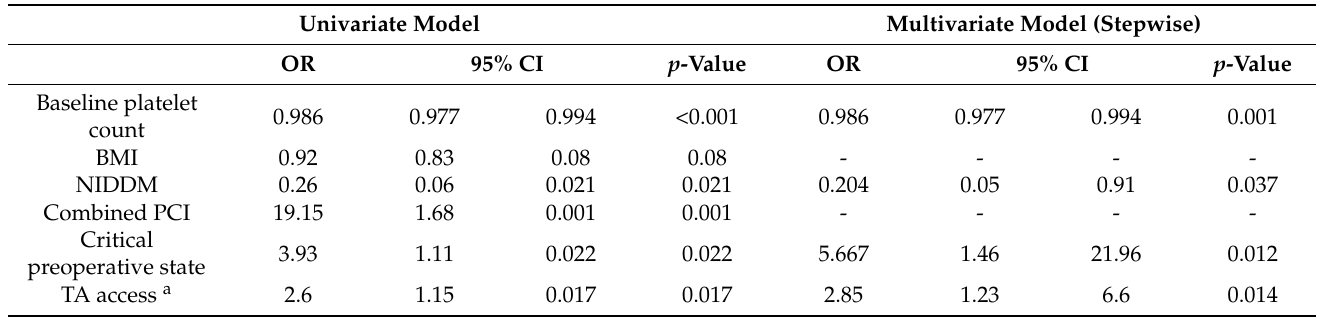
Table 3. Independent factors of severe thrombocytopenia at logistic regression